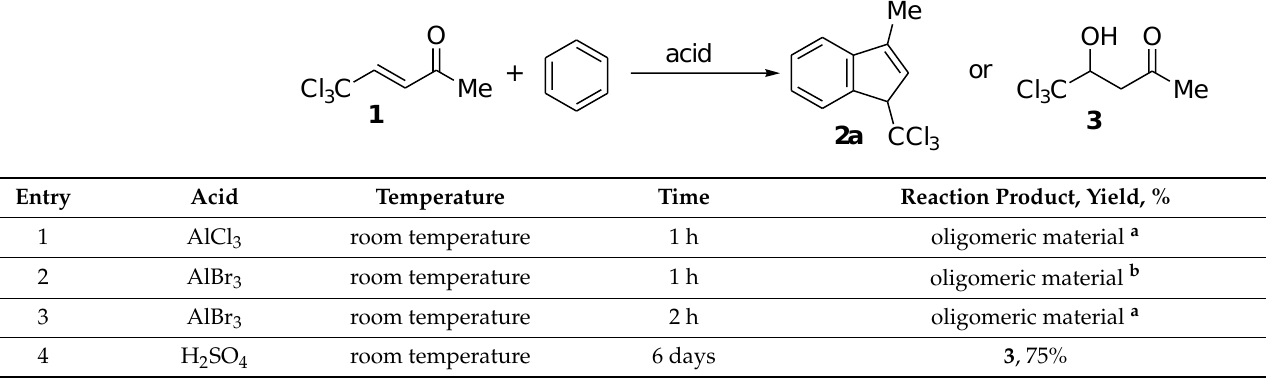
orbital into the molecular orbital. d Gibbs energy of protonation reactions. Reactions of CCl 3 -enone 1 with benzene under the action of various Brønsted and Lewis acids have also been conducted (Table 3). The use of strong Lewis acids AlCl 3 or AlBr 3 yields complex mixtures of oligomeric materials (entries 1 – 3). Reaction in H 2 SO 4 results in the formation of alcohol 3 as a product of hydration of the carbon-carbon double bond; no reaction with benzene occurs (entry 4). Reaction in Brønsted superacid CF 3 SO 3 H (triflic acid, TfOH) at room temperature for 5 days affords indene 2a in yields 29% (entry 7). Under other conditions (temperature and time) in CF 3 SO 3 H, the formation of 2a is un- satisfactory (entries 5, 6, 8, 9), as is the reaction in stronger acid FSO 3 H at a low tempera- ture of − 78 C (entry 10). In weaker acids, CH 3 CO 2 H and CH 3 CO 2 H, the reaction does not take place (entries 11-14). These data reveal that the formation of indene 2a in CF 3 SO 3 H is accompanied by cationic oligomerization processes, which leads to a decrease in the yield of the target compound. The formation of indene 2a points out that the starting compound 1 in CF 3 SO 3 H behaves as a precursor of the bi-centered electrophile, with reactive cationic centers on carbons C 2 and C 4 . Table 3. Reactions of CCl 3 -enone 1 with benzene under the action of excess of various acids.